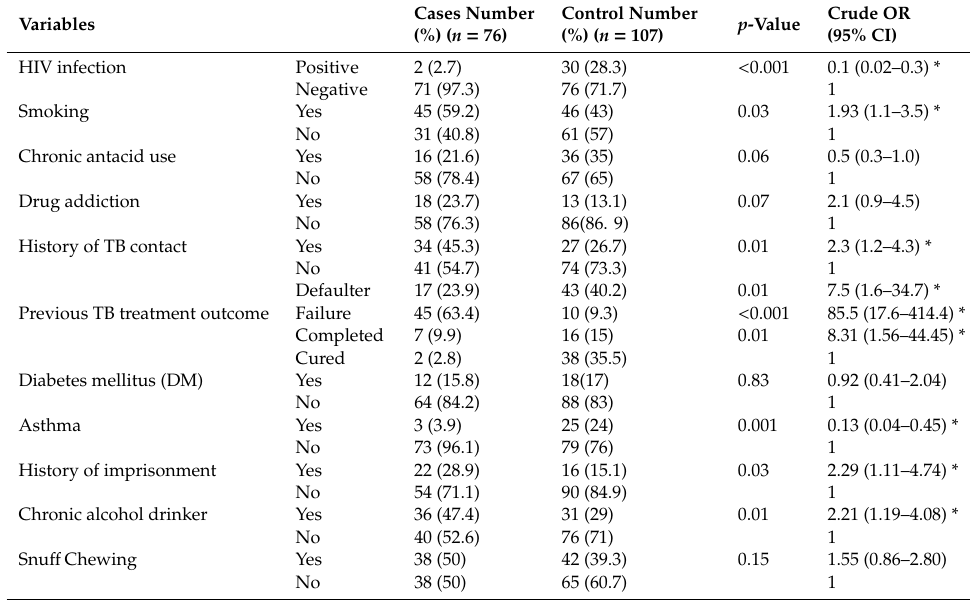
Table 2. Association of clinical and behavioral factors with multidrug-resistant tuberculosis (MDR-TB) among MDR-TB